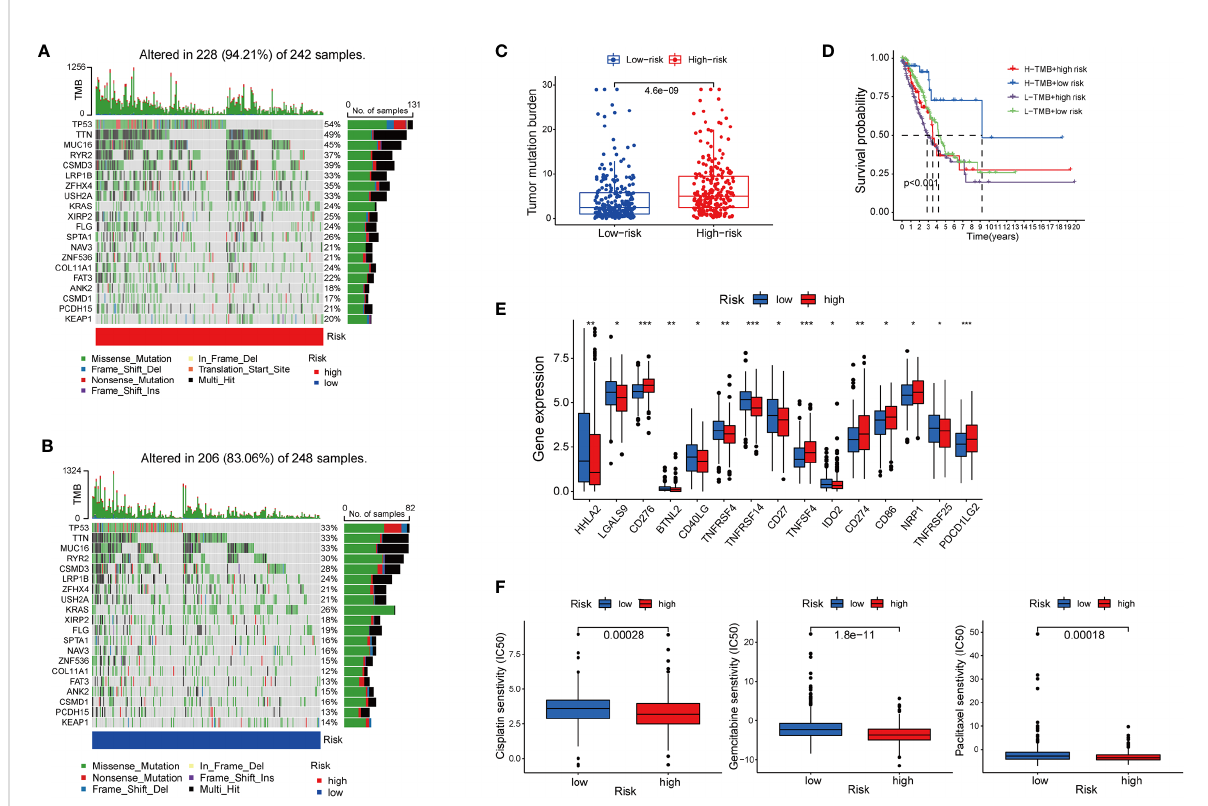
FIGURE 6 The association between cuproptosis status and sensitivities to immunotherapy and chemotherapy. (A, B) Mutations of tumor-associated genes in the high- (A) and low-risk (B) groups. (C) TMB of the high- and low-risk LUAD group. (D) Kaplan-Meier curves show the overall survival of patients with different TMB statuses and cuproptosis-based LUAD risks. (E) Expression of immune checkpoints in the high and low-risk groups. (F) Sensitivities to cisplatin, gemcitabine, and paclitaxel of the high- and low-risk group identi fi ed by cuproptosis statuses (*, p<0.05; **, p<0.01' ***,